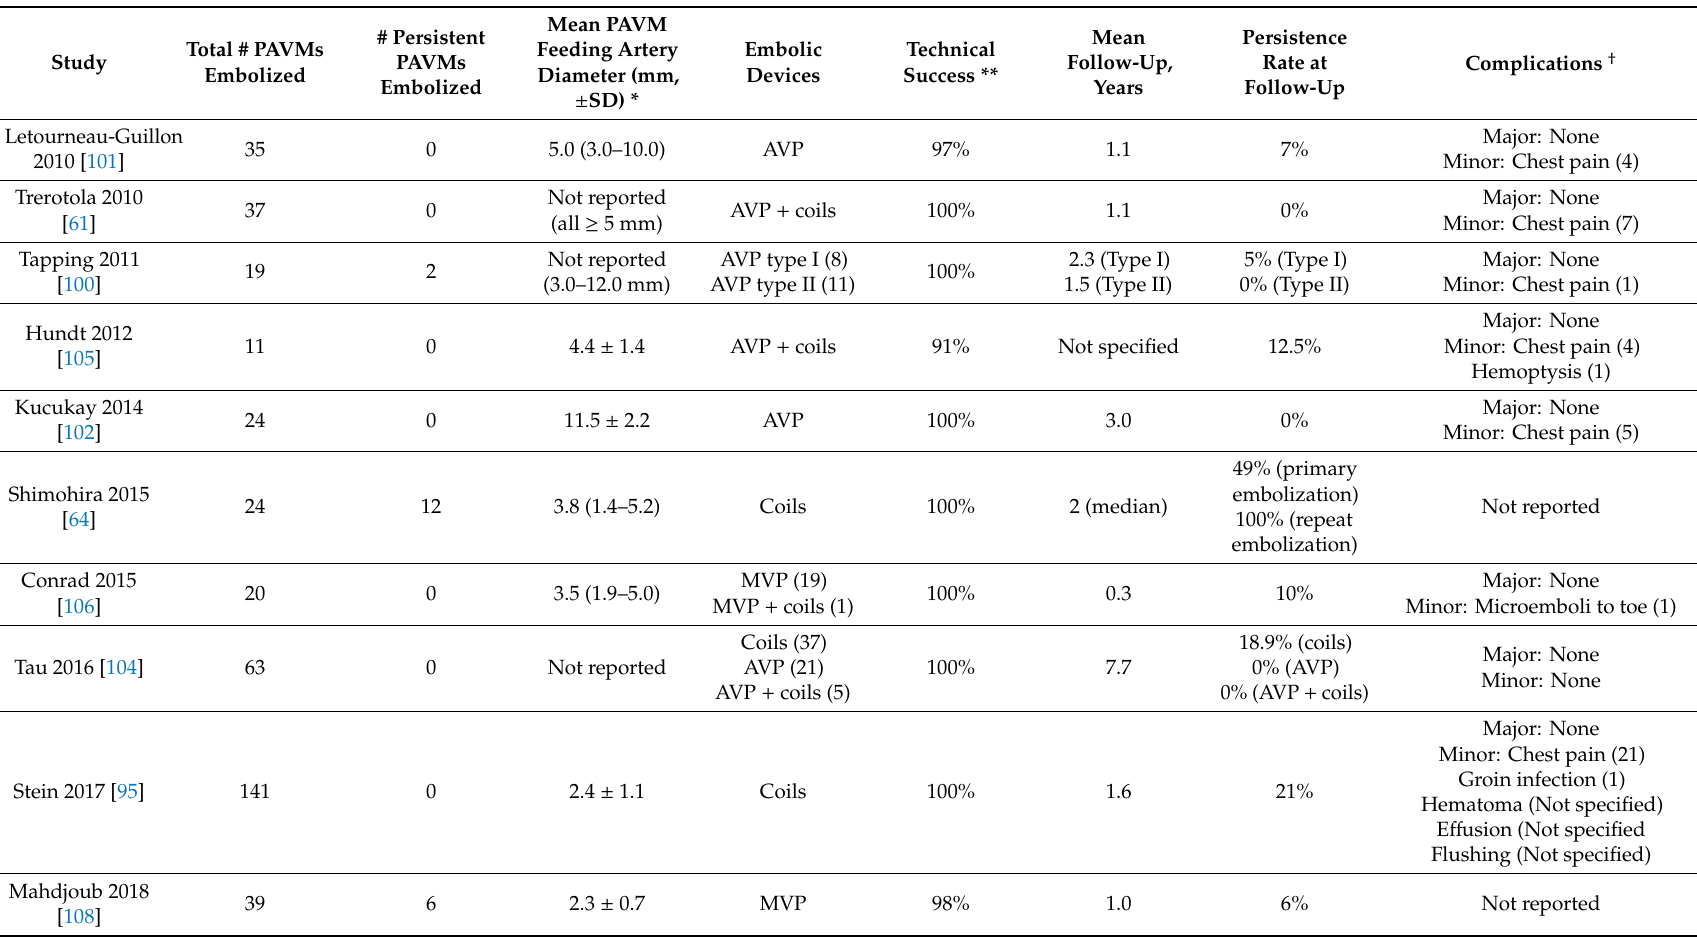
Table 1. Summary of literature on PAVM embolization outcomes of various embolic devices published in the last 10